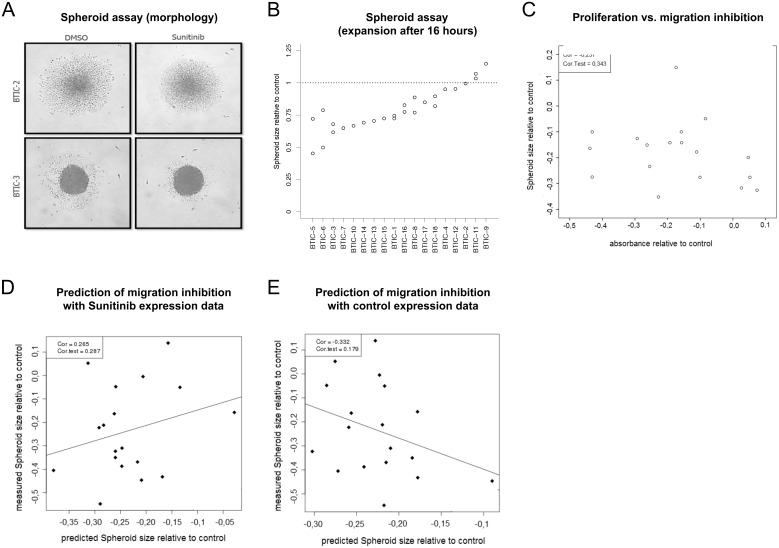
Migration under Sunitinib examined by multicellular spheroid expansion assay.Spheroids were incubated with 1 µM Sunitinib or 0.00025% DMSO (control) in a round-bottomed 96 well plate. Radial expansion of BTICs from the spheroid was recorded after 16 hours incubation. (A) Representative pictures of two differently responding BTIC lines (BTIC-2 and BTIC-3) show different patterns of migration. (B) The relative difference of the mean covered area relative to control is blotted in a dot blot graph (y-axis) against the corresponding BTIC line (x-axis). (C) The mean spheroid size relative to control (y-axis) is blotted against the corresponding relative proliferation inhibition (x-axis) for each of the 18 BTIC lines. (D) Failed prediction of migration on gene expression 6 h after treatment in vivo. The x-axis shows cross validated predictions of migration, while the y-axis shows the actual migration measurements. There is no significant correlation between predictions and measurements (p = 0.287). (E) Failed prediction of migration using expression values from untreated samples. There is no significant correlation between predictions and measurements (p = 0.179).